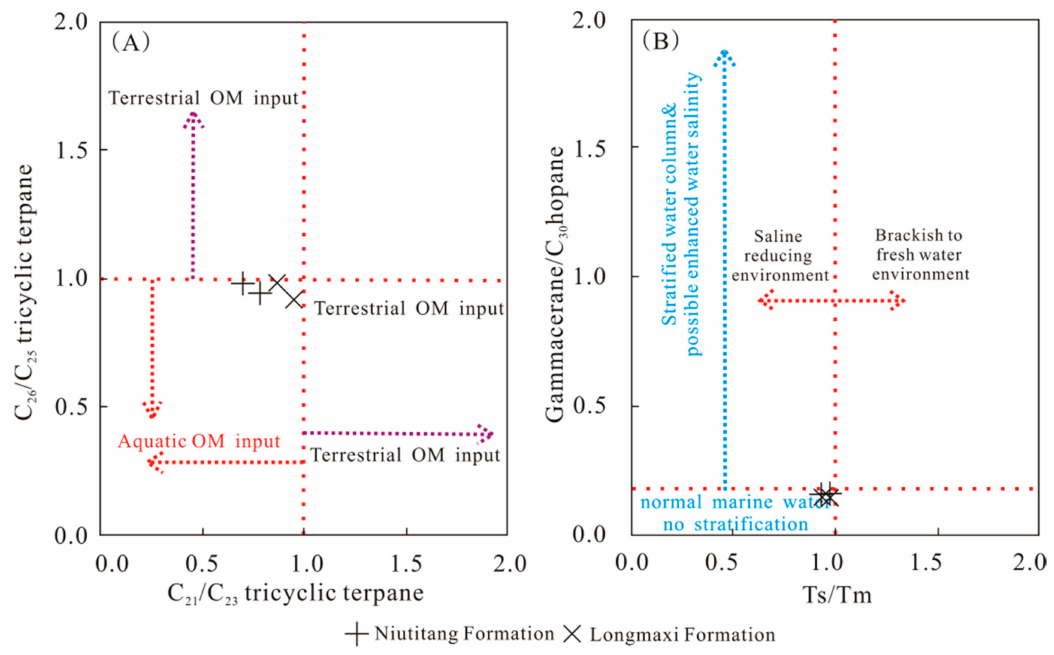
Figure 10. Cross diagrams of C 21 /C 23 tricyclic terpane versus C 26 /C 25 tricyclic terpane ( A ), and the Ts/Tm versus C 30 hopane ( B ). ( A , B ) Base map is from Gao et al.